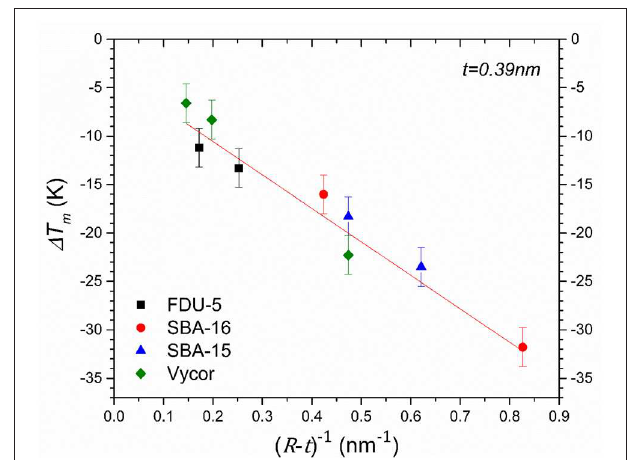
FIGURE 5 | Depression of melting point as a function of inverse of effective pore radius. Red straight line through the data points is a linear least-squares fit of the simplified Gibbs-Thomson equation 1 T m = K / ( R − t ) where t is the thickness (0.39nm) of the statistical monolayer of water molecules attached to the pore wall. Data for Vycor-5, Vycor-109, and Vycor-145 samples are taken from a previous study [15].